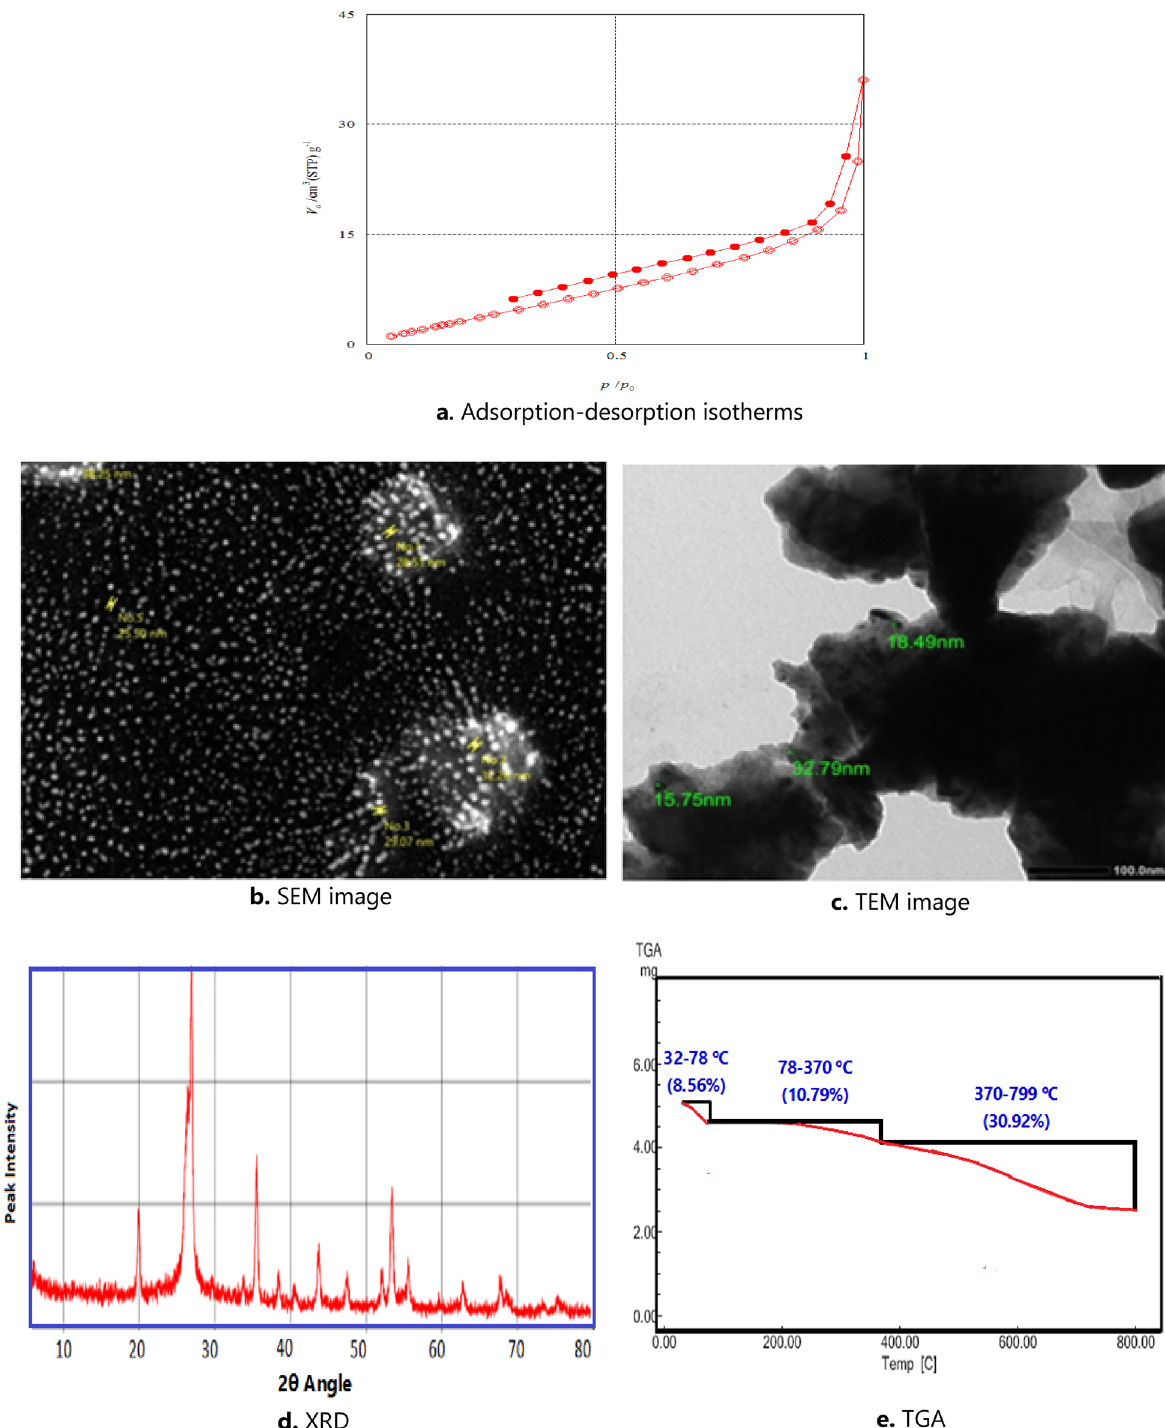
Figure 3. Different characterization patterns of Gel@GO-F-ZrSiO 4